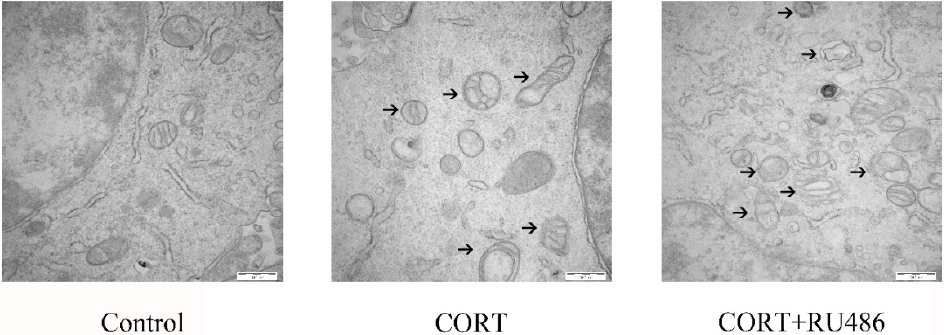
Figure 10. Mitochondrial damage due to autophagy in HT22 cells was observed by electron microscopy after 400 µ M cortisol treatment for 3 h with or without RU486 treatment. The damaged mitochondria were indicated with black arrows.